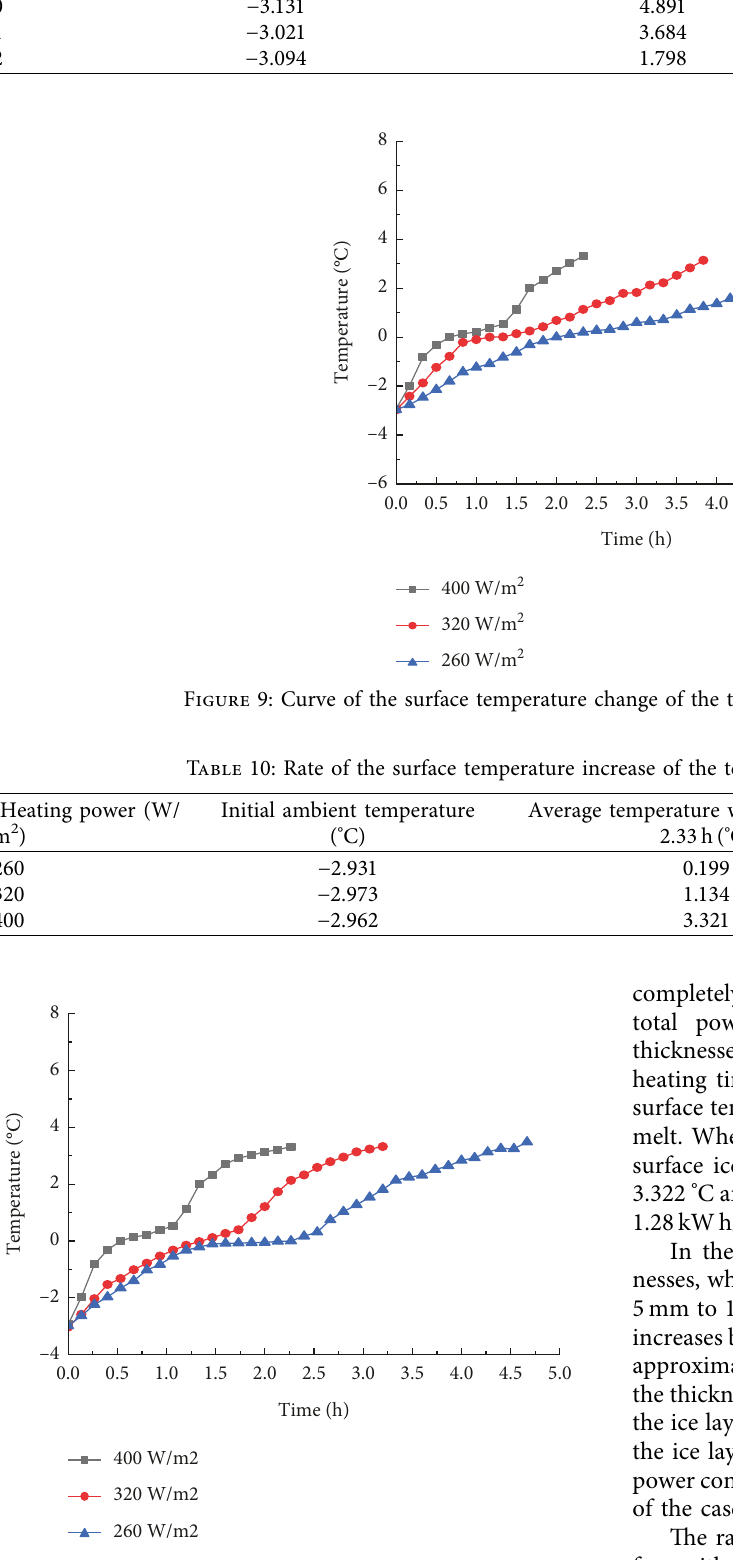
Figure 10: Temperature change curve of the specimen surface with different ice